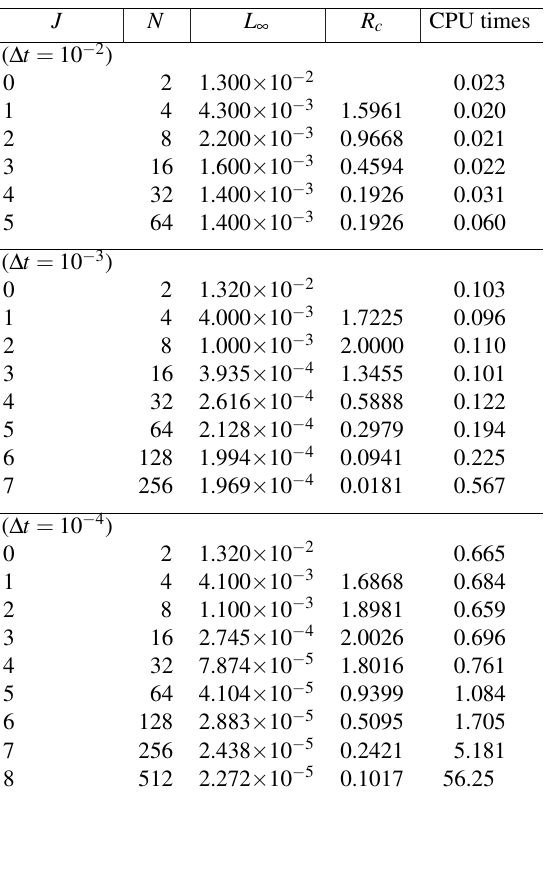
Table 6. Numerical results at t = 1 for Test Problem 8